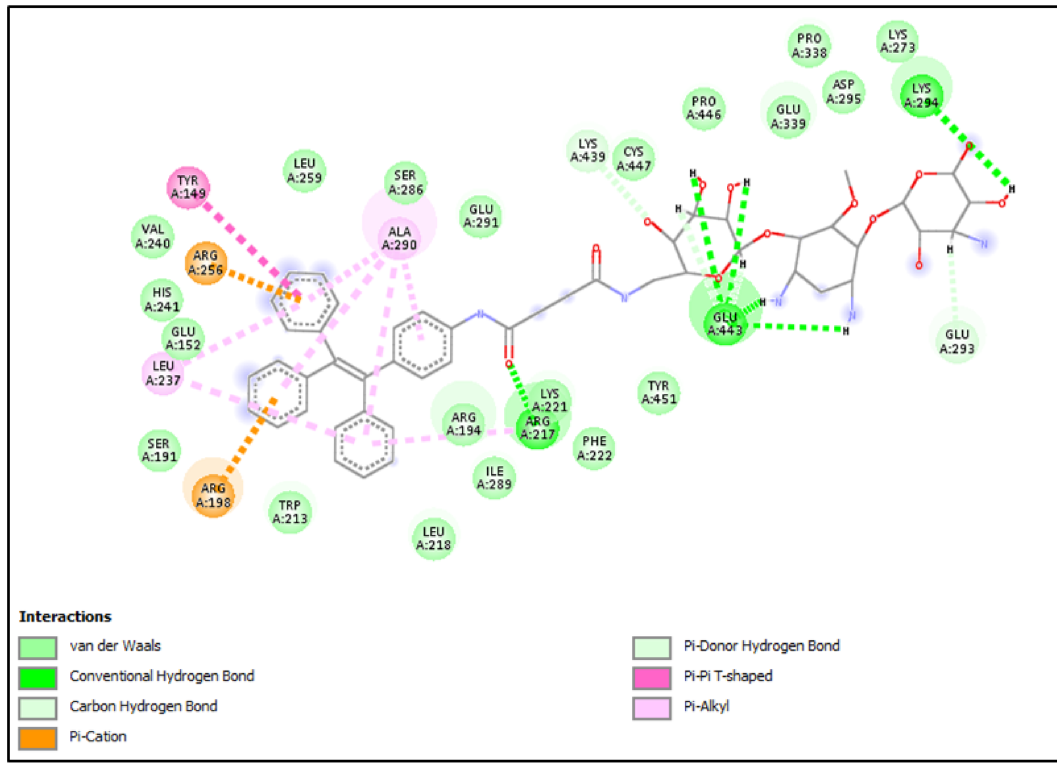
pocket residue of BSA protein. The 2D interaction network image was generated using Discovery studio Visualizer (BIOVIA, 2016) 35